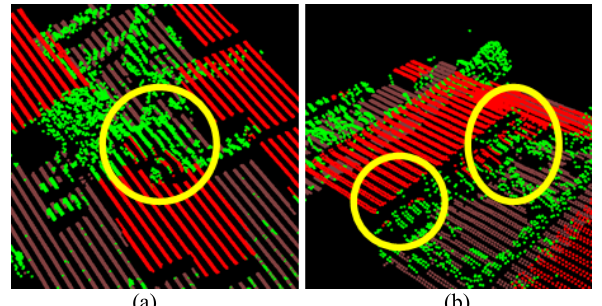
Figure 8: Some poor performances (red: buildings, green: vegetation, brown: